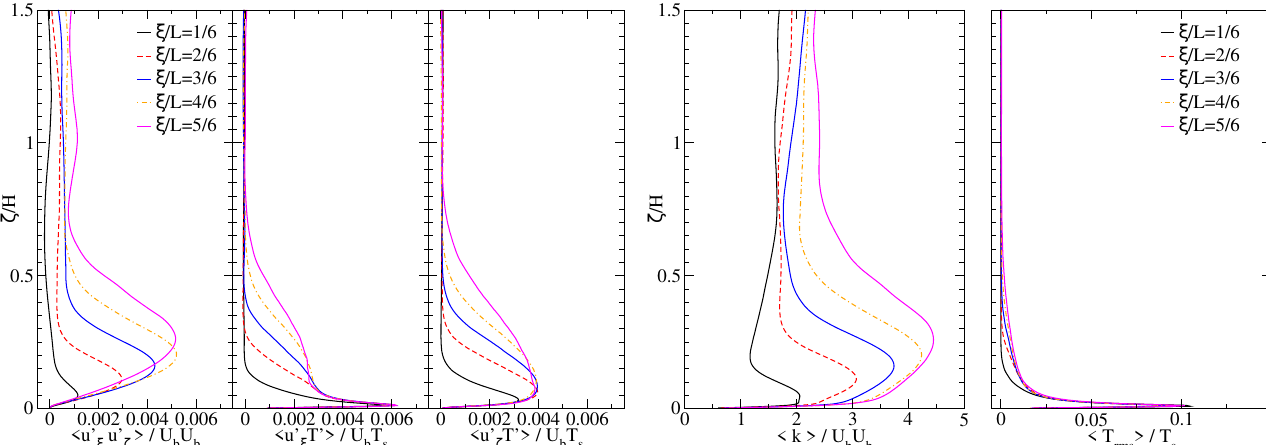
Figure 9. Non-dimensional mean turbulent quantities in the system of reference of the slope: turbulent kinematic momentum (cid:105) , slope-parallel turbulent heat flux (cid:104) u (cid:48) u (cid:48) flux (cid:104) u (cid:48) ξ ζ (cid:104) k (cid:105) = (cid:104) u (cid:48) (cid:105) , temperature perturbation RMS T rms . Profiles along selected slope-normal lines (same as in Figure u (cid:48) i i